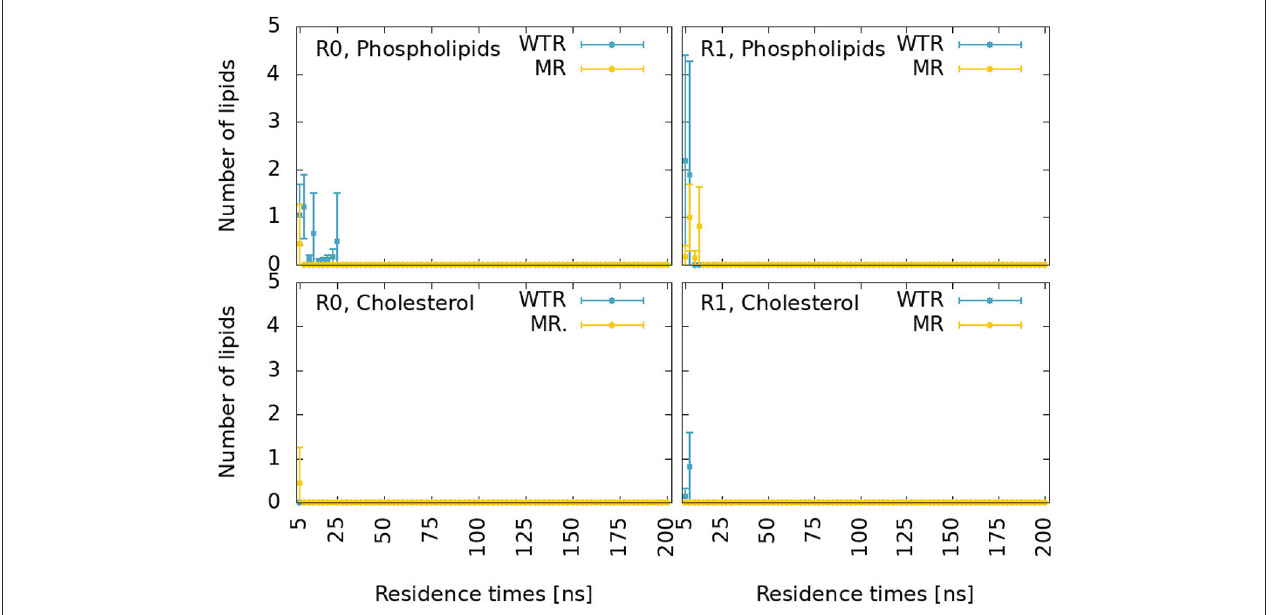
FIGURE 11 | Proximity lifetime distributions of any phospholipid (top) and of any cholesterol (bottom) in close proximity to residue 441 in the WTR (blue) and in the MR (yellow) for replicas R0 (left) and R1 (right) . The results are shown for residence times larger than 5 ns.